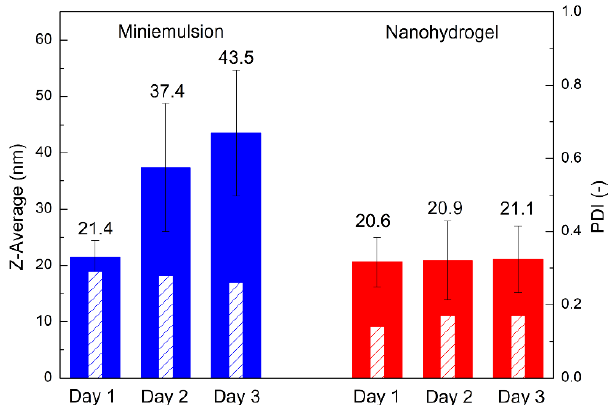
Figure 3. Comparison between miniemulsion (sample M6) and nanohydrogel (sample H2) size (left-hand y axis) and PDI stability (right-hand y-axis) over time.